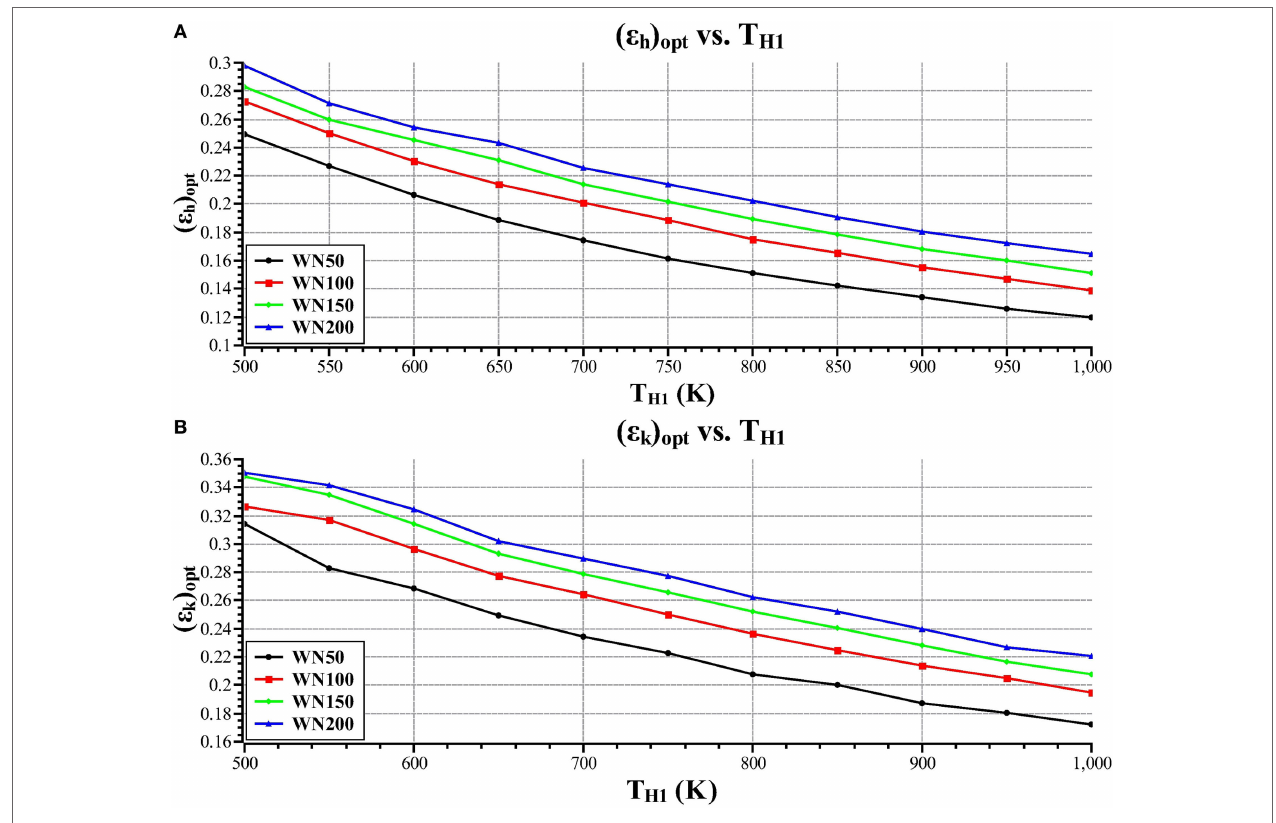
FIGURE 11 | Optimal heater effectiveness (A) and cooler effectiveness (B) versus heater inlet temperature.